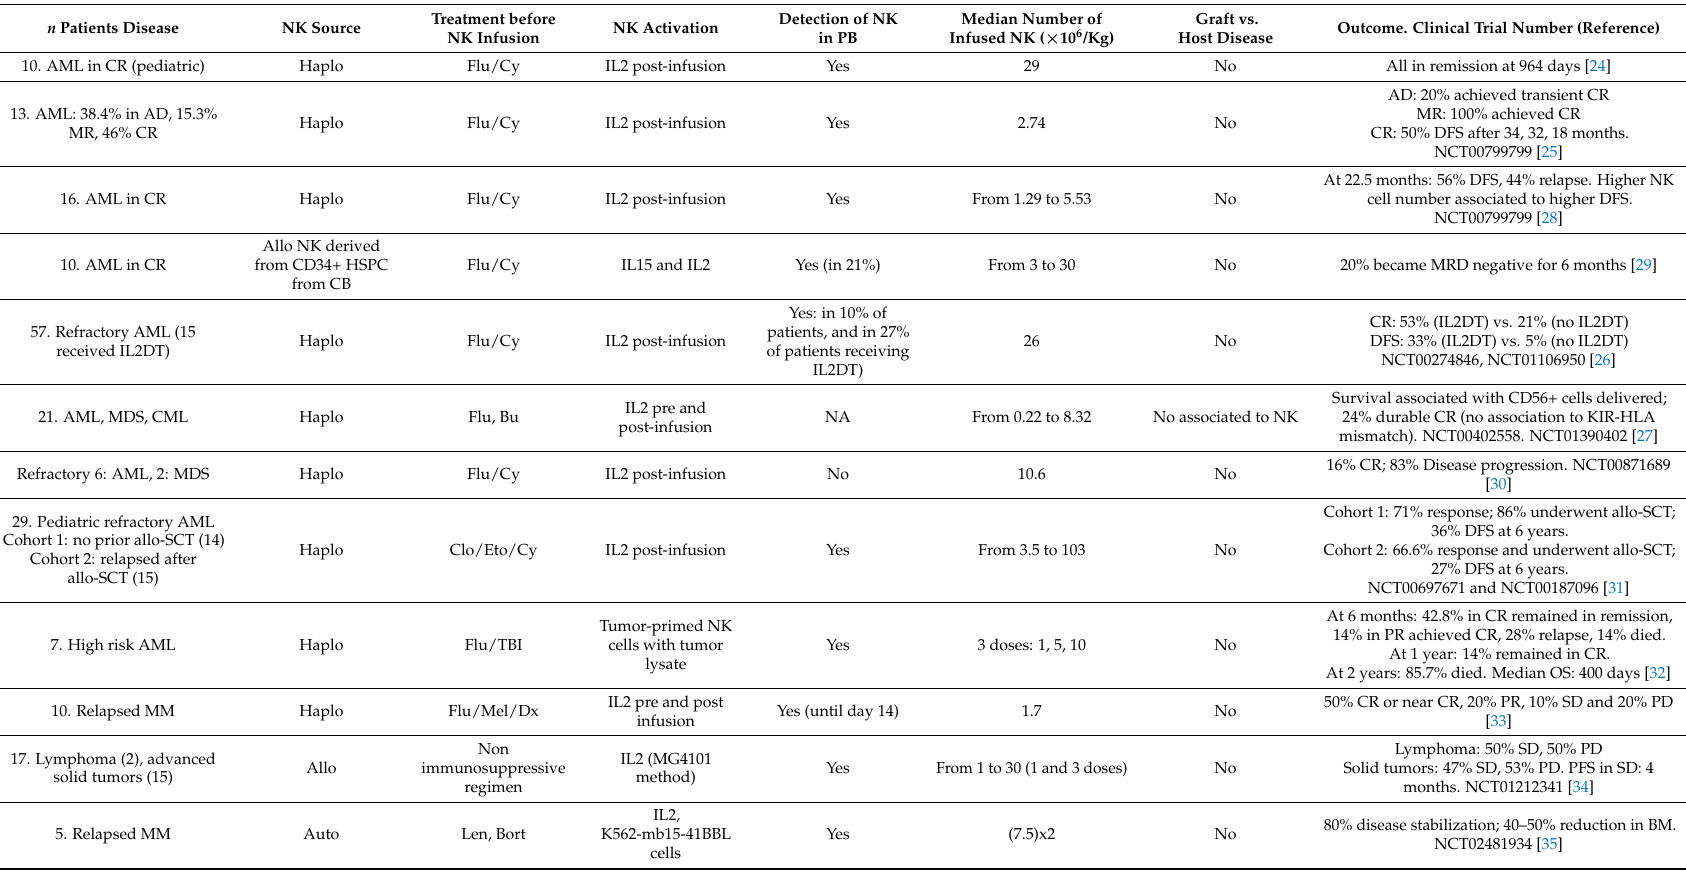
Table 1. Clinical studies performed with NK (natural killer) cells as immunotherapy